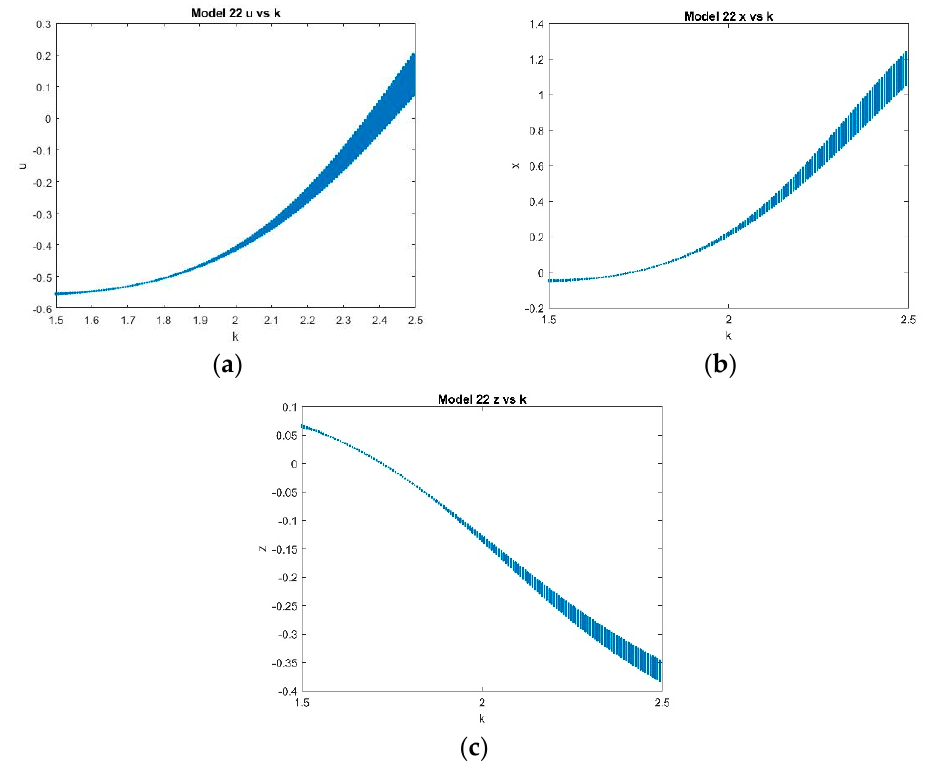
Figure 19. MCEFD model (22); ( a ) u vs. k , ( b ) x vs. k , ( c ) z vs. k , at p = 1, α 5 = 0.3, k ∈ [ 1.5, 2.5 ]